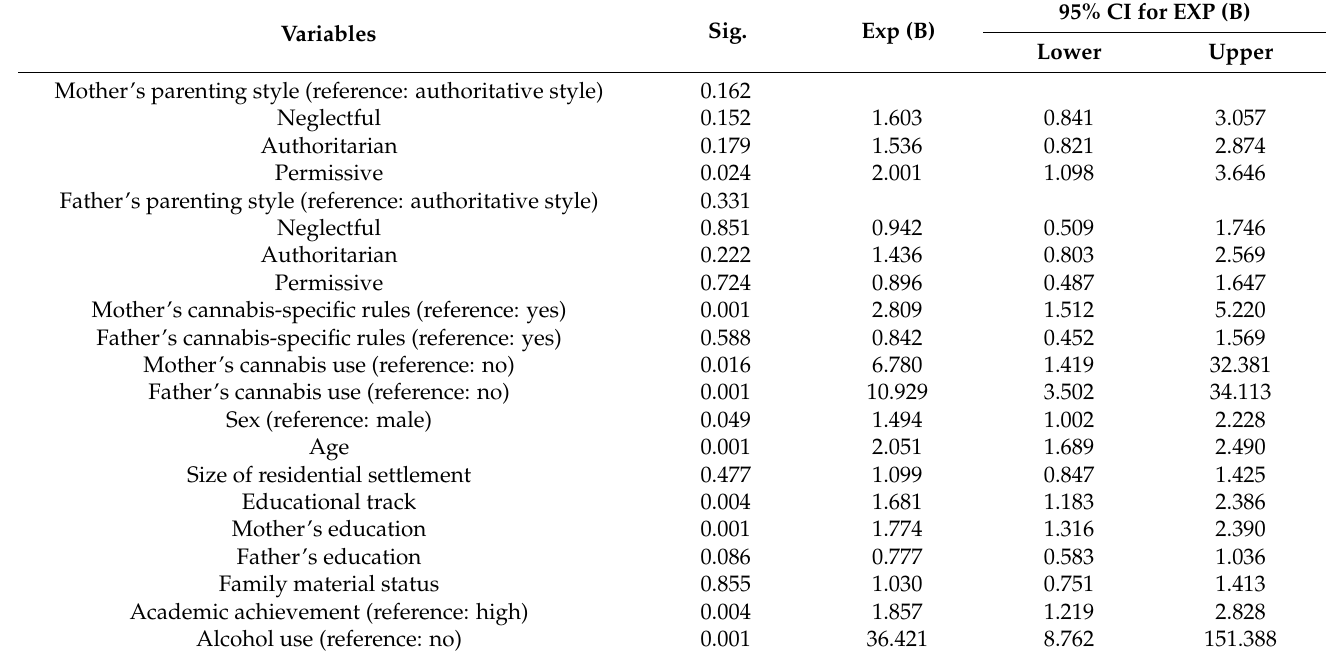
Table 2. Association between the adolescents’ lifetime cannabis use, parenting practices and con- founding